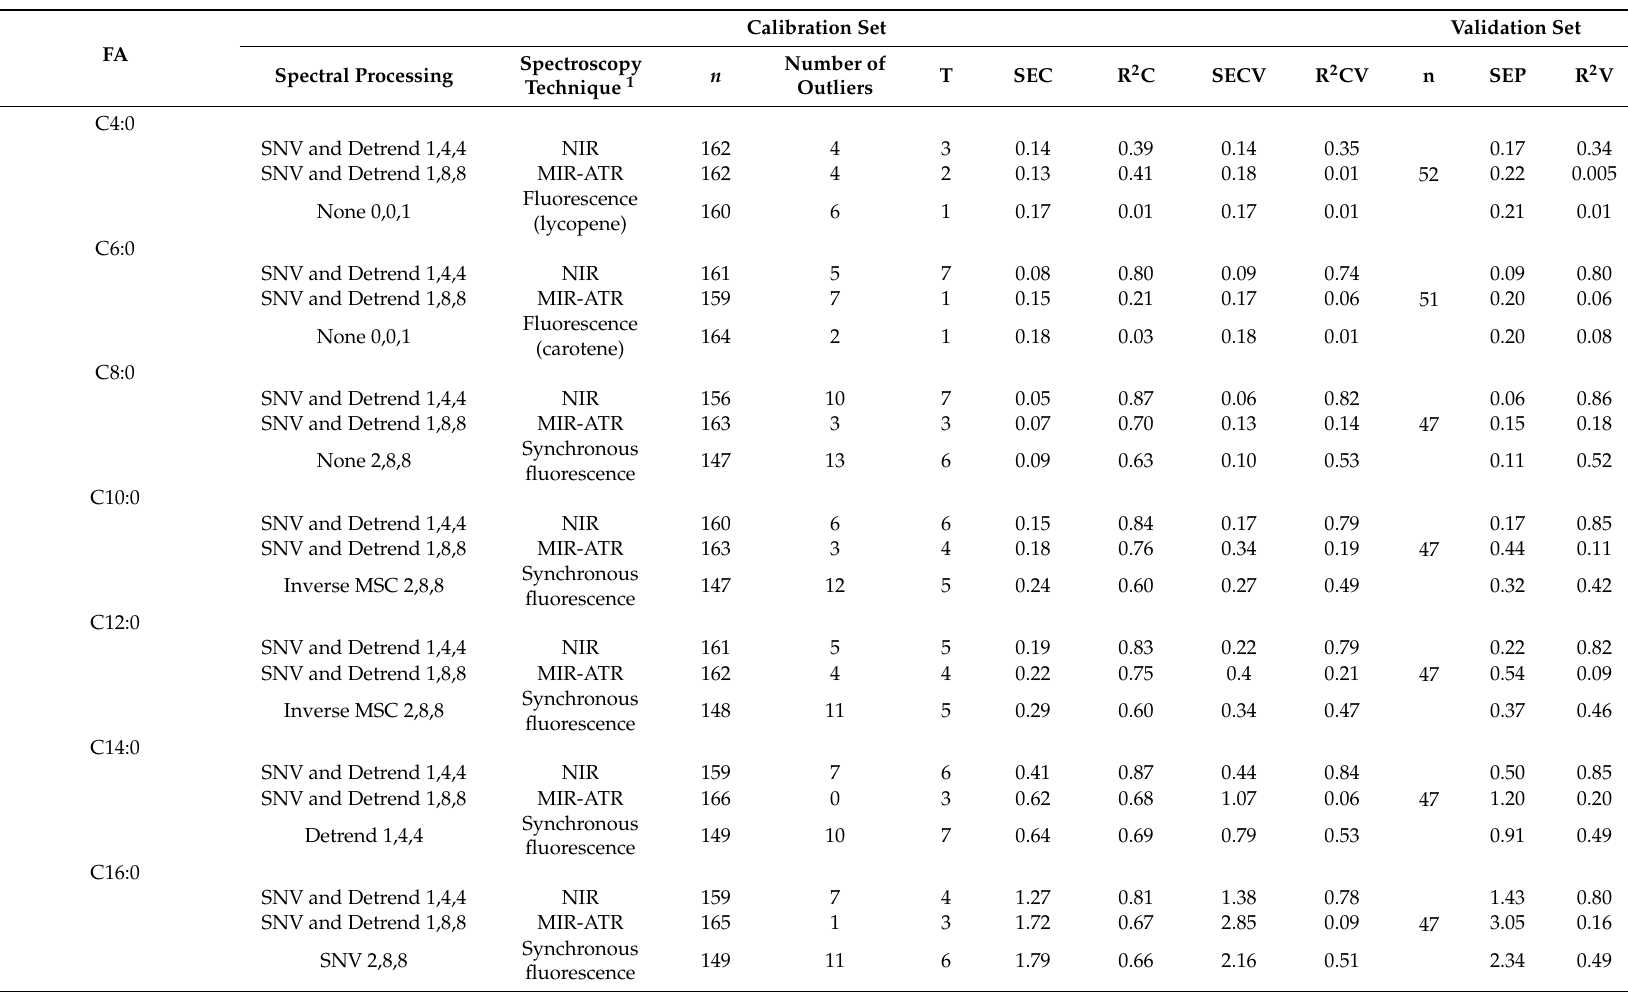
Table A2. Prediction of di ff erent fatty acids (FA, expressed in g fat / kg of milk) in cow milk according to the equation developed from three spectroscopy techniques: near-, mid-infrared (NIR and MIR, respectively) and fluorescence